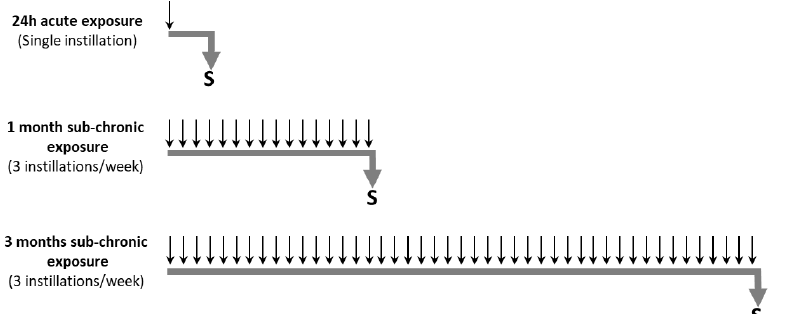
Figure 1. Experimental protocol of acute and subchronic exposures of mice to FF and UFP. Particles were suspended in 40 µL of HBSS. In the acute exposure, mice were sacrificed (S) 24 h after receiving a single dose of particles (10, 50 or 100 µg). For the subchronic exposure, the mice were exposed 3 times a week for 1 or 3 months to 10 µg of particles. Control mice received HBSS without particles. Arrows pointing down mean intranasal instillations of a dose of HBSS, FF or UFP.